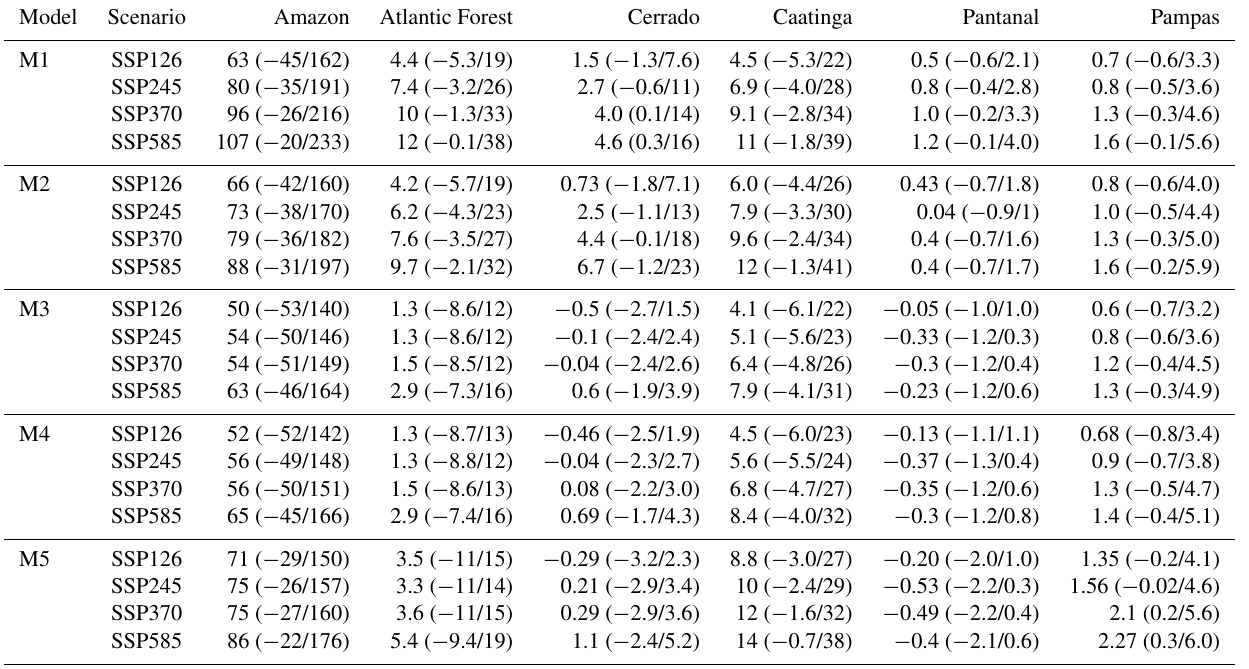
Table A4. Climate-change-scenario-specific estimates of biomass change (2001–2100) by DALEC for each of the Brazil biomes (Fig. 1). Units are PgC and values in parentheses are the 5% and 95% quantiles defining the 90% confidence interval. For clarity, values are rounded to the nearest PgC or two significant figures. SSP126 indicates SSP1-2.6Wm − 2 , SSP245 indicates SSP2-4.5Wm − 2 , SSP370 indicates